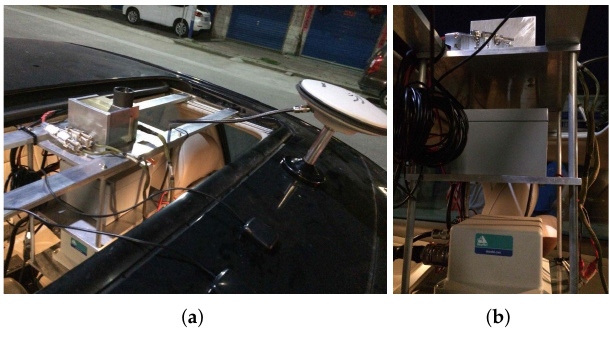
Figure 1. Hardware design of the INS/GPS/Bei-Dou2(BD2)/Celestial Navigation System (CNS) integrated navigation system. ( a ) Hardware view1; ( b ) Hardware